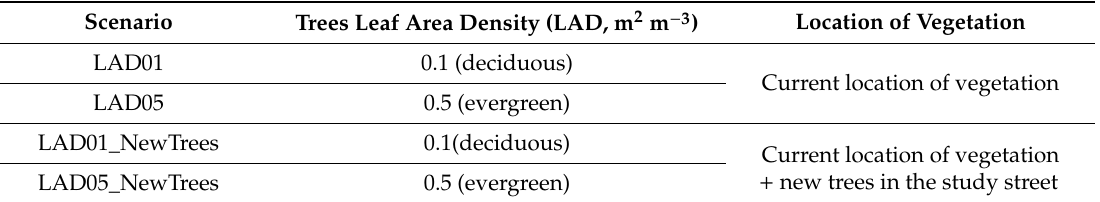
Table 1. Scenarios investigated by computational fluid dynamic (CFD)